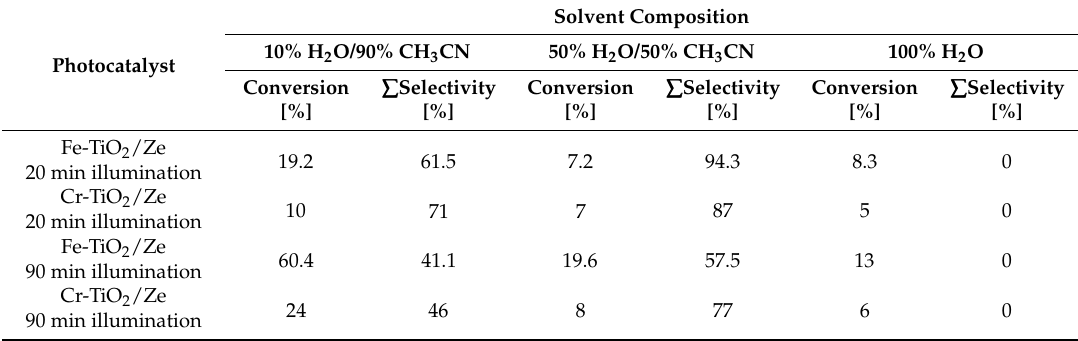
Table 4. Effects of solvent composition on glucose conversion and selectivity towards glucaric/gluconic acids using TiO 2 doped with Fe 3+ or Cr 3+ supported on Ze developed by Colmenares et al. [33,34].